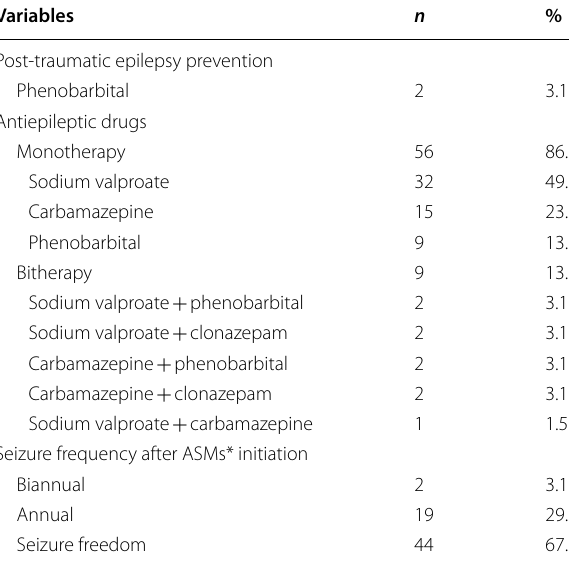
Table 5 Anti‑seizure medication and seizure